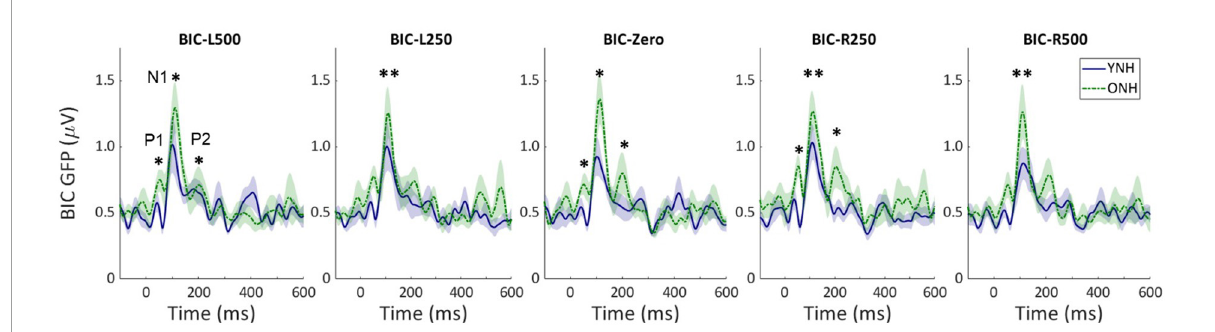
FIGURE4 Grand average sensor-based global-field power (GFP) responses for the derived binaural interaction component (BIC) responses for each interaural time difference (ITD) condition and each listener group (YNH–blue solid, ONH–green dashed). The shaded region around each curve represents the ± 1 standard error (SE) of the mean. The three main peak components are labeled in first panel (P1, N1, P2). Asterisks indicate significant group differences with the following p -values: ∗ p < 0.05, ∗∗ p < 0.01 .